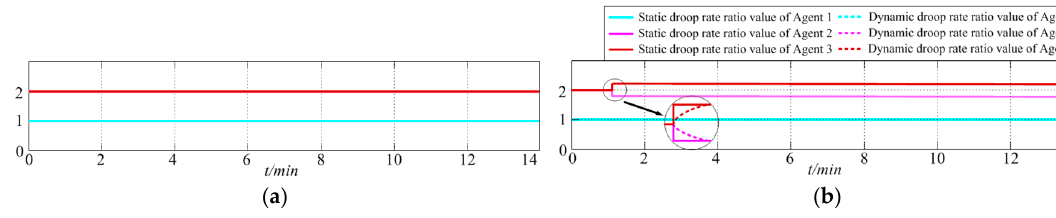
Figure 12. Static and dynamic droop rates between DGs. ( a ) Static droop rate ratio; ( b ) Static and dynamic droop rate ratio.